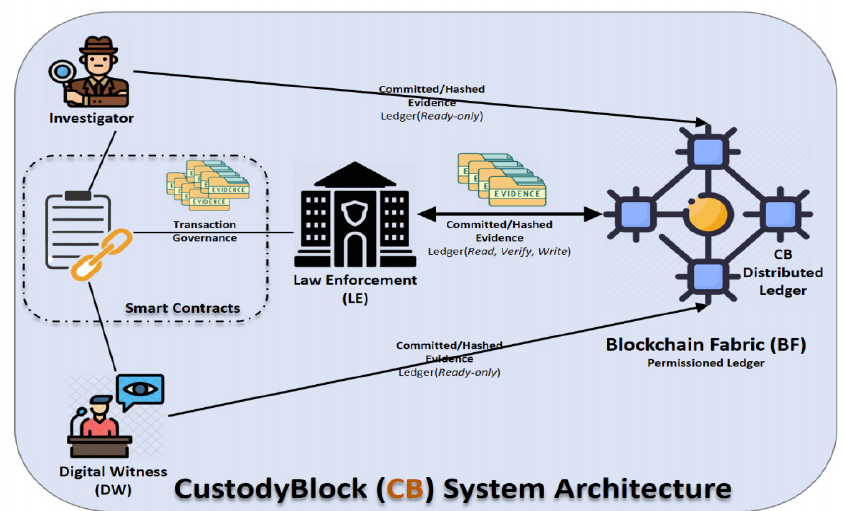
Figure 3. CustodyBlock framework.